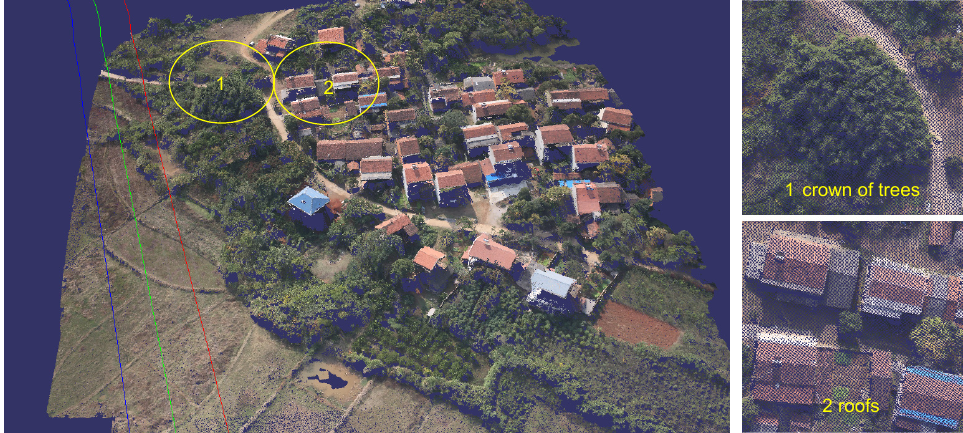
Figure 6. Dense 3D Point Clouds Extracted by SPMEC (the three colorful lines represent three power lines).